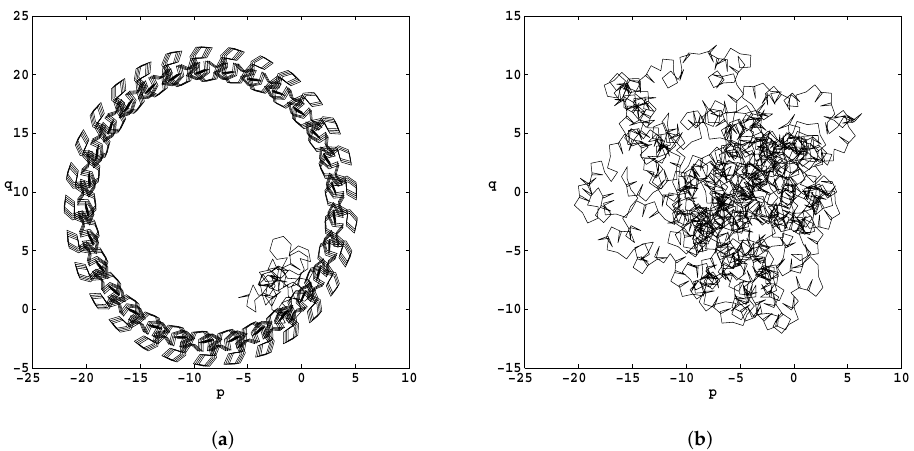
Figure 6. The 0-1 test results. Variables q − p without ( a ) and with ( b ) the XOR operation with the chaotic bits from the Chua (Matsumoto) circuit. The logistic map with µ = 3.99 used in ( a , b ) for a sequence of 7th bits with numbers of length 18 bits. The K = 0.2079 in ( a ) and K = 0.9874 in ( b